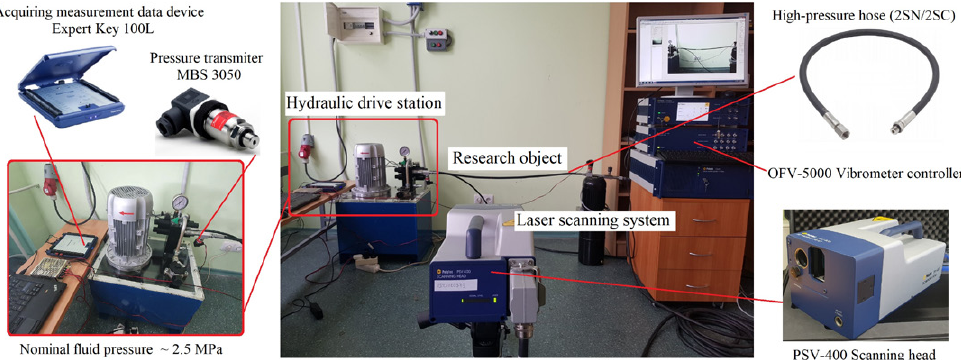
Figure 4. The test bench for experimental measuring